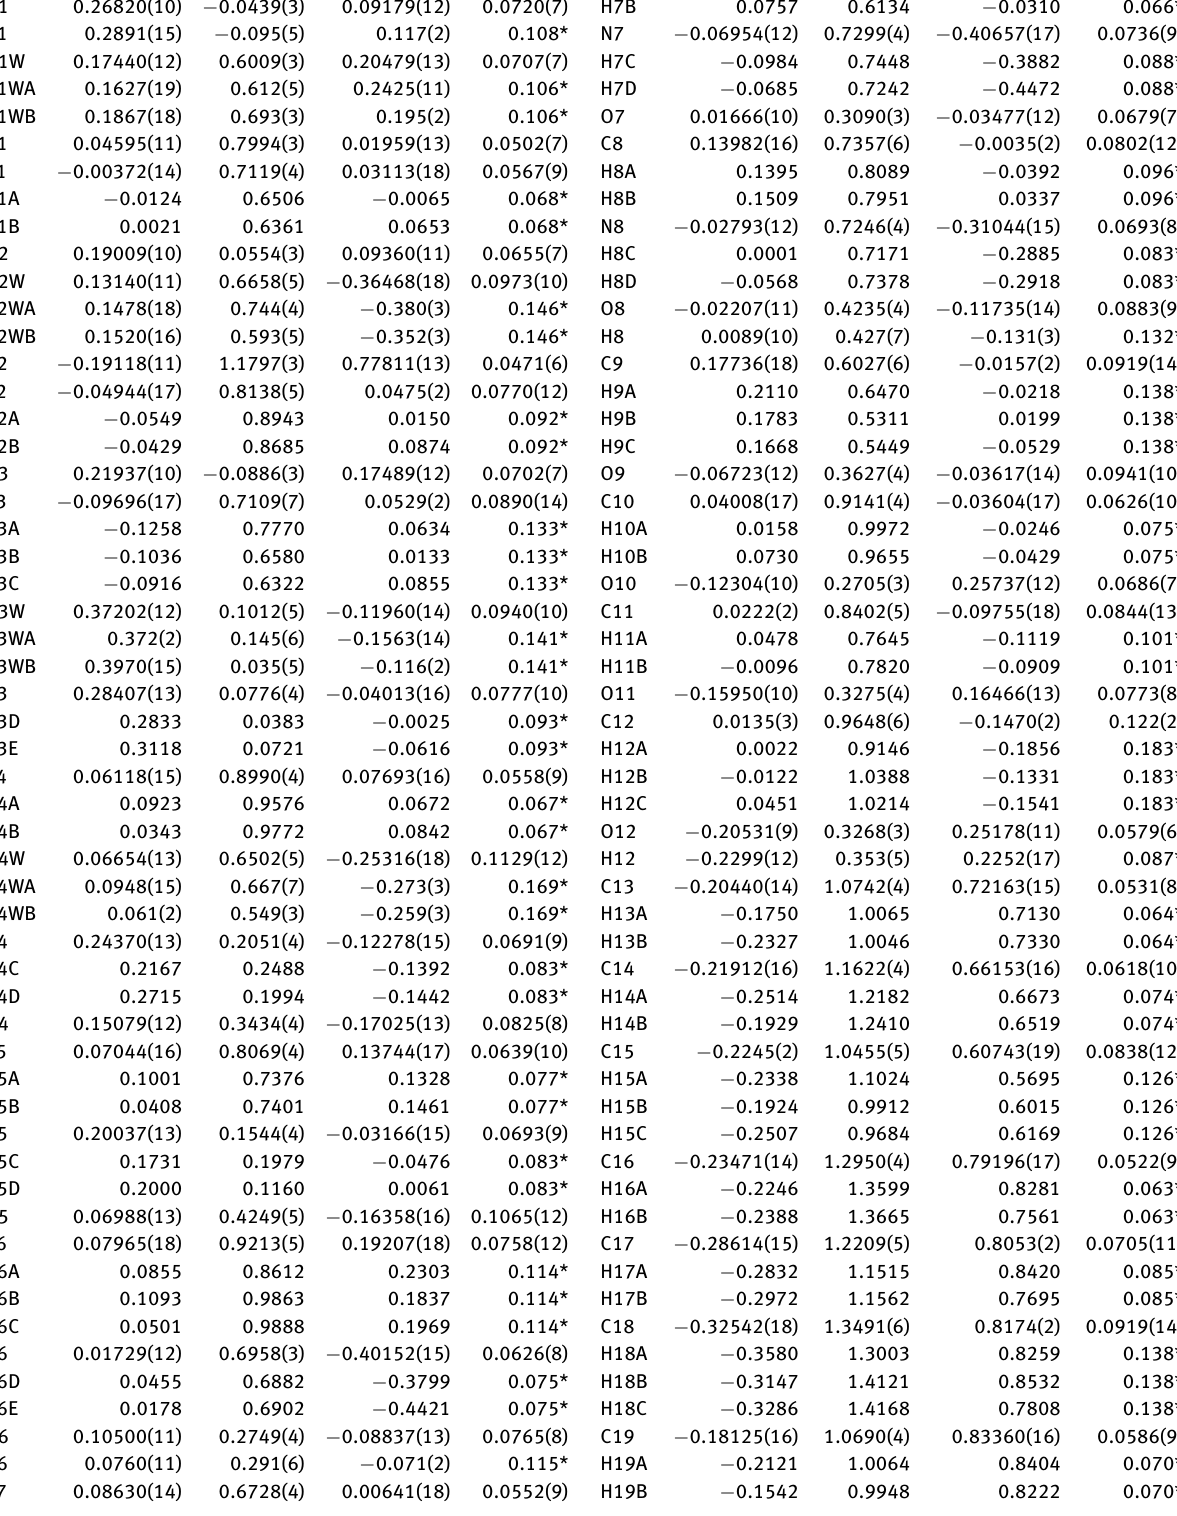
Table 2: Fractional atomic coordinates and isotropic or equivalent isotropic displacement parameters (Å 2